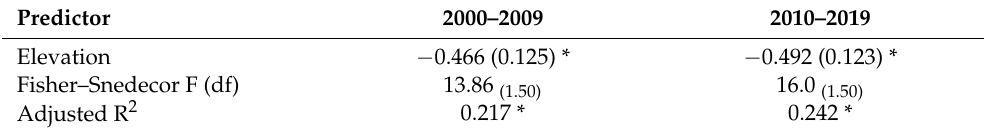
Figure 5. A reverse U-shaped form of the log-log relationship between birth rate and population density characteristic of urban, suburban, and rural districts in Greek prefectures ( left : 2000–2009, right : 2010–2019). Table 1. Results of a forward stepwise regression analysis identifying the most relevant predictors of general fertility rates in Greek prefectures ( n = 51); standard errors in parentheses; * p <